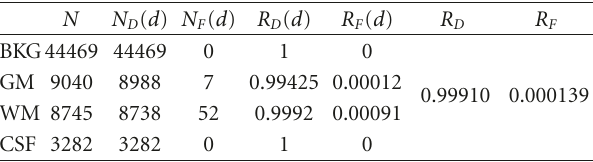
Table 1: Assessment results of AIS-CSA